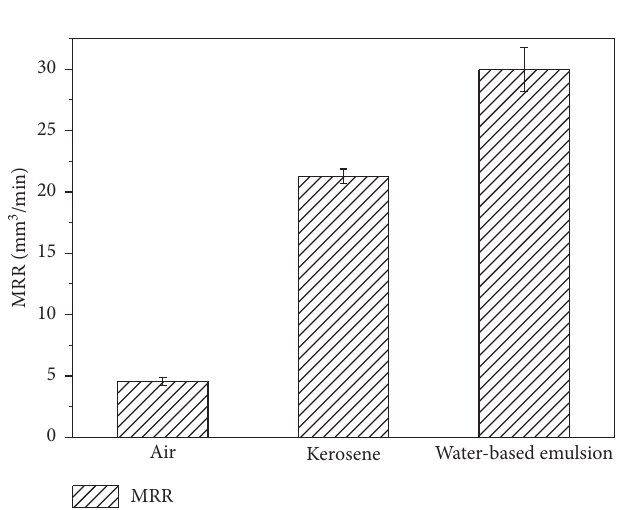
Figure 2: MRR comparison in 3 different working